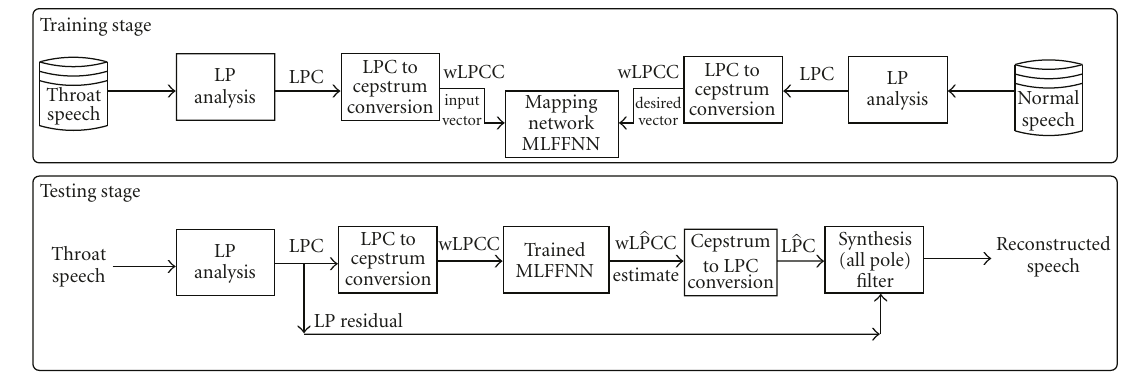
Figure 3: Block diagram of the proposed approach for modeling the relationship between the TM speech and the NM speech of a speaker.